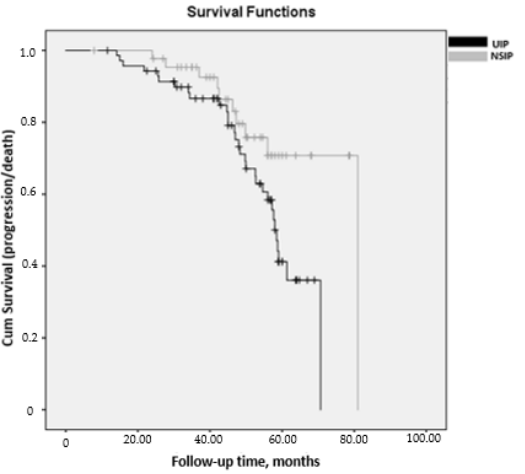
Table 4. Comparison of progression of symptoms and lung disease in patients with RA-ILD accord- ing to radiological pattern (UIP or NSIP).